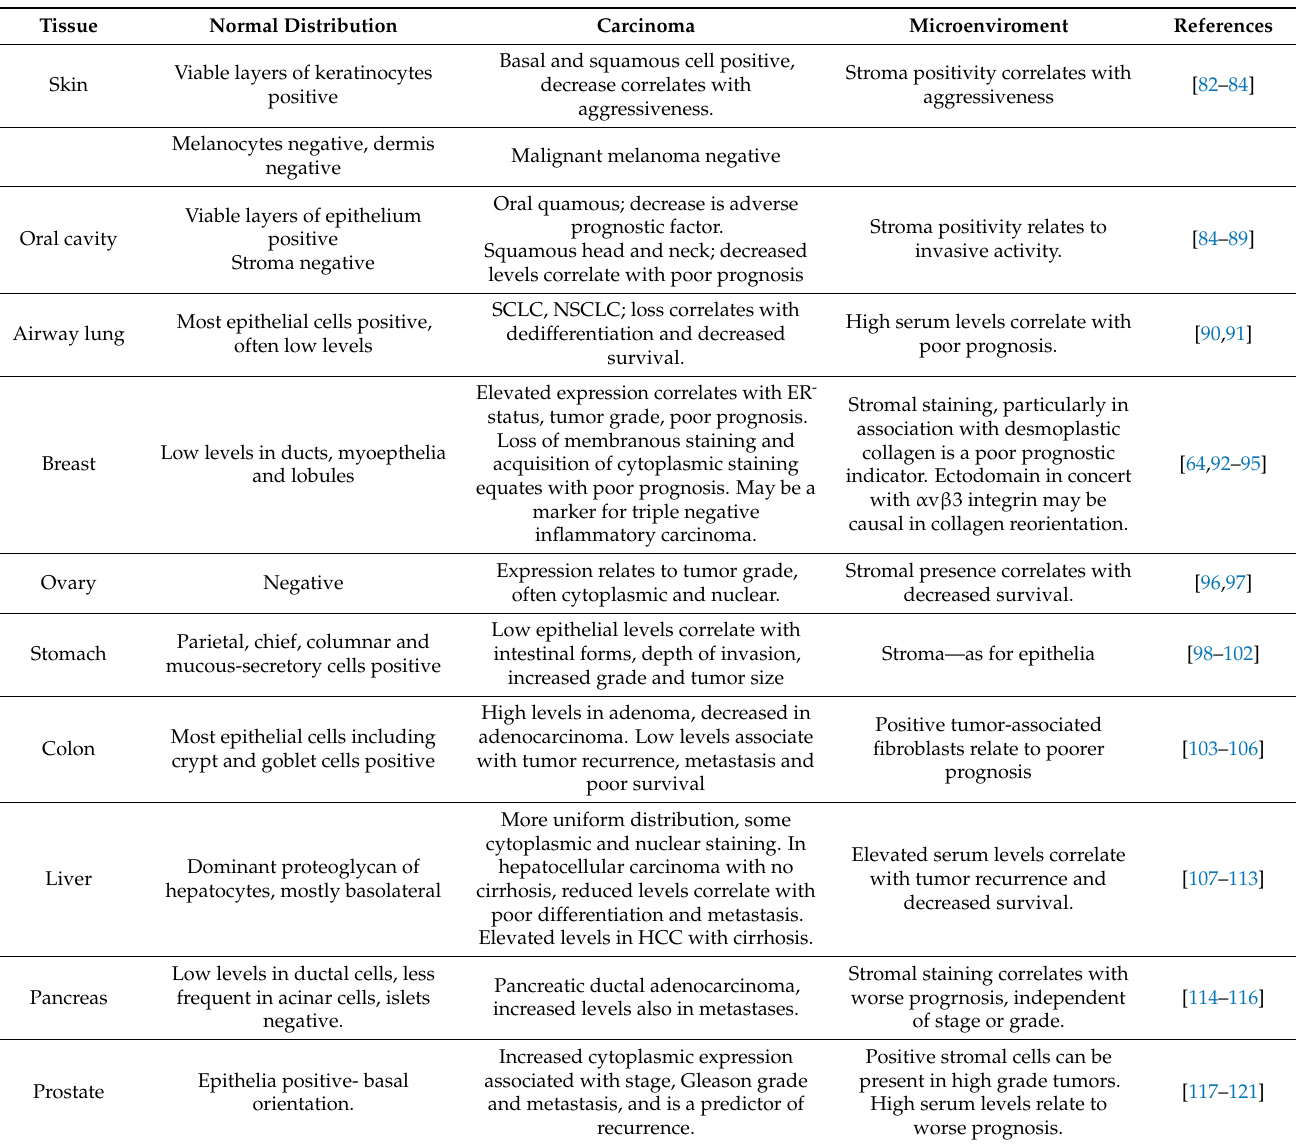
Table 1. Syndecan-1 (CD138) in